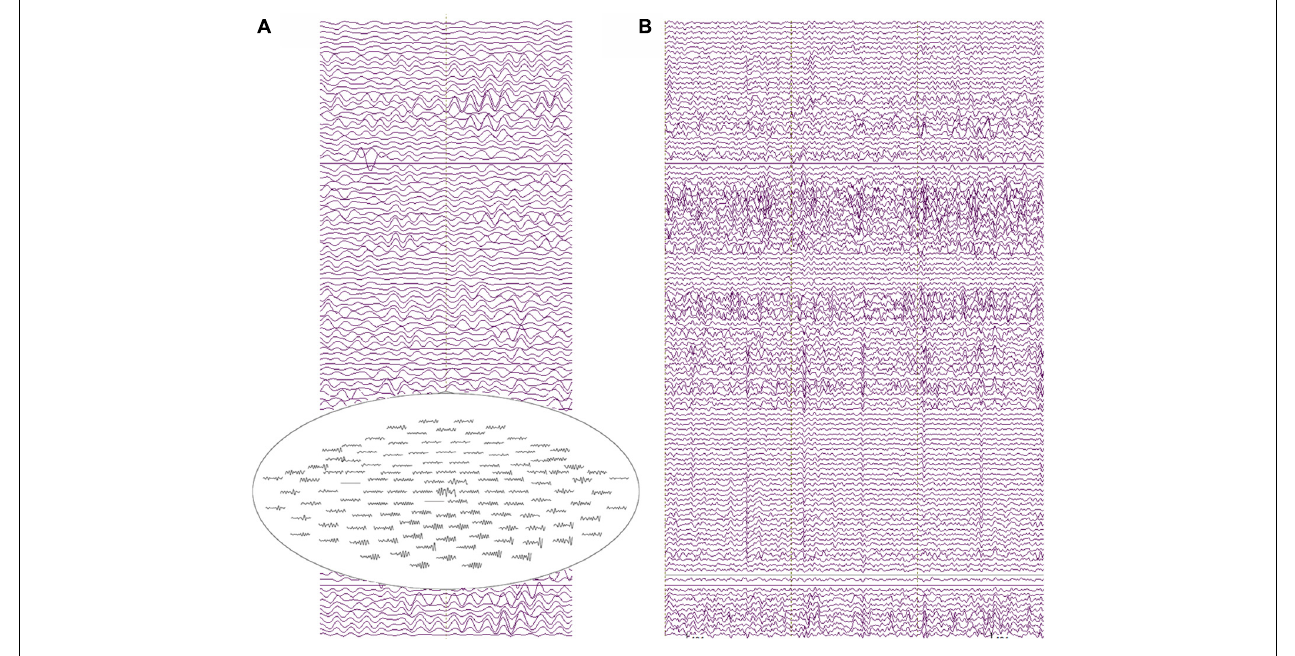
FIGURE 6 | (A) Two seconds of resting-state recordings from an 18-month-old participant. Several channels exhibit resolvable alpha activity in the resting MEG data with increased amplitude from posterior sensor locations (see the